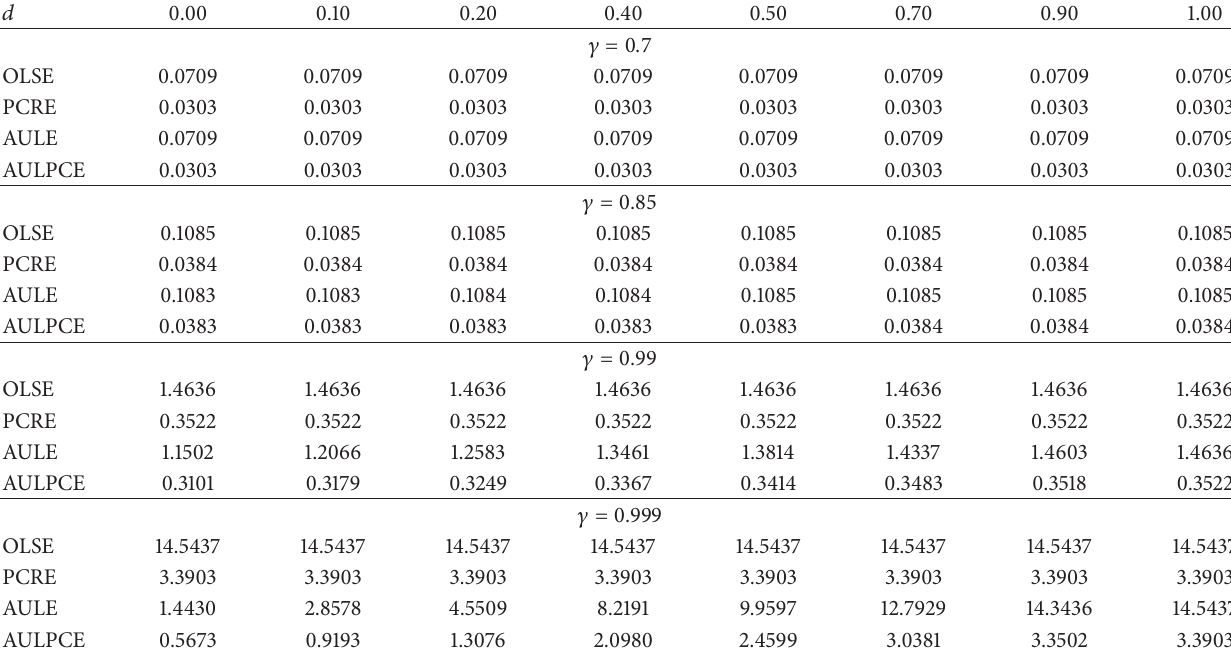
Table 2: MSE values of the OLSE, PCRE, AULE, and